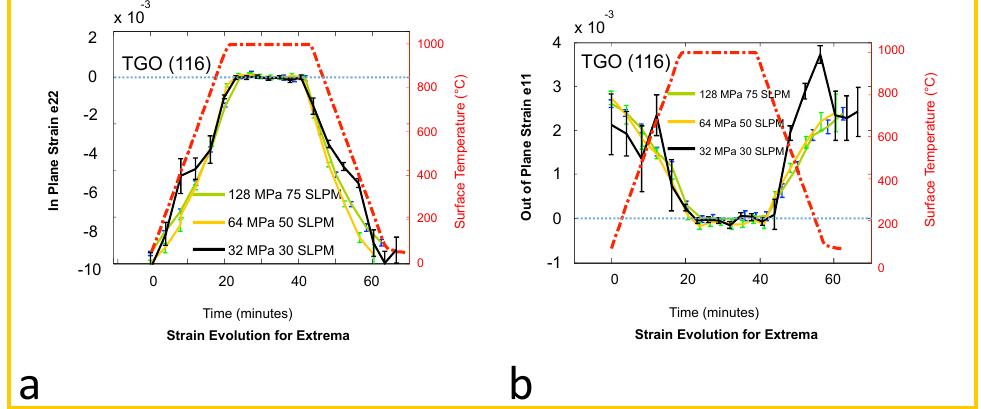
Figure 3. Extrema plots to show strain evolution at low, medium, and high mechanical load and respective internal flow: ( a ) in plane strain; and ( b ) out of plane strain.